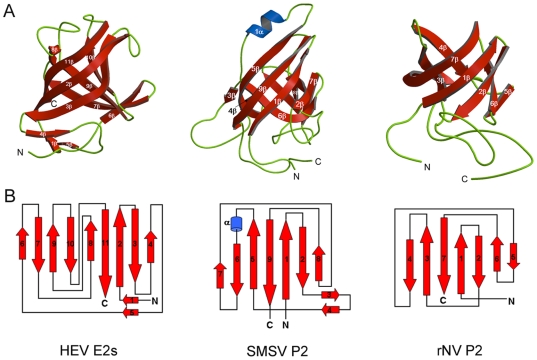
Structural comparison of E2s with P2 domains.
(A) Side-by-side ribbon diagram of HEV-E2s, the SMSV-P2 domain (pdb code 2gh8) and the rNV-P2 domains (Pdb code 1ihm). β-strands and α-helices are numbered. N- and C-termini are also labeled. These figures were prepared using Molscript and Raster3D [32],[33]. (B) Topology diagrams of HEV-E2s, the SMSV-P2 domain and the rNV-P2 domain. β-strands, α-helices and connecting loops are represented by red arrows, blue cylinders and green lines respectively.